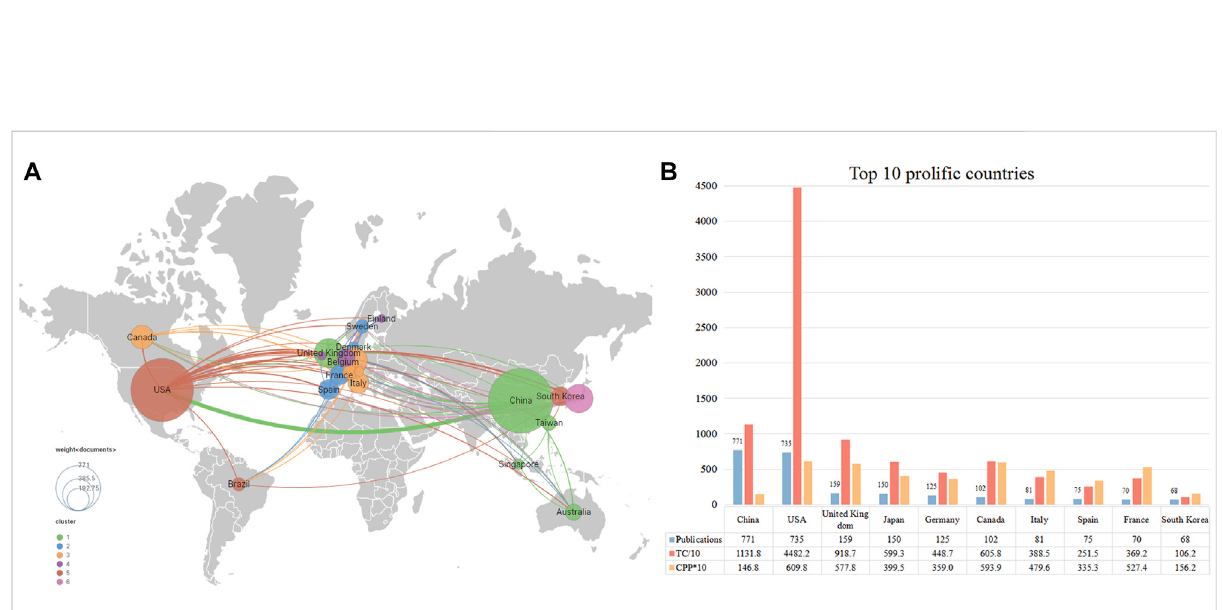
FIGURE 3 The top 10 most productive countries and international co-operative network. (A) Collaboration among proli fi c countries which published more than 10 papers. Node size represents the number of publication, the width of the link is positively correlated with the strength of cooperation. (B) The number of publications, total citations (TC), and citations per publication (CPP) of the top 10 most productive